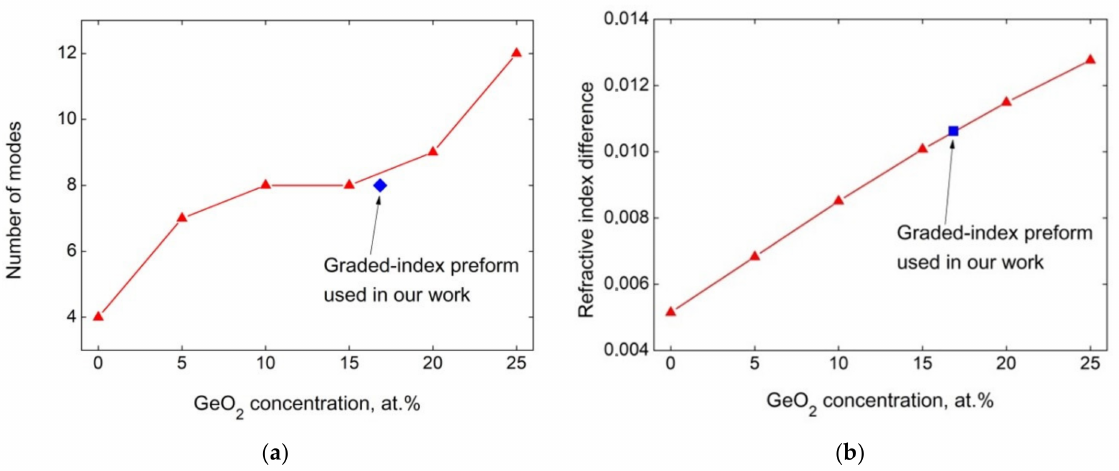
Figure 7. Calculated number of modes ( a ) and refractive index difference between the first and second excited modes ( b ) depending on the GeO 2 concentration of the six-core-MOF based on the core elements with graded-index profile.